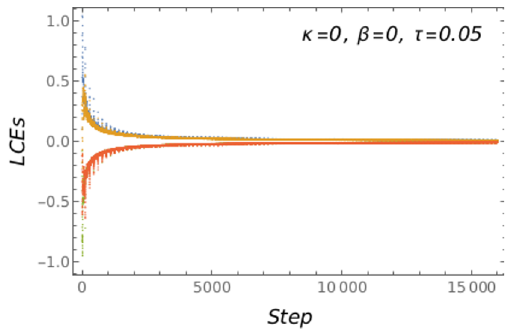
Figure 10 . Plot of the full LCE spectrum for the undeformed SU (3) Landau-Lifshitz model. The initial conditions are p θ (0) = 3 / 10 , p ψ (0) = 11 / 10 , θ (0) = 1 , ψ (0) = 1 . The total evolution time is T = 800 which is broken into 16000 iterative